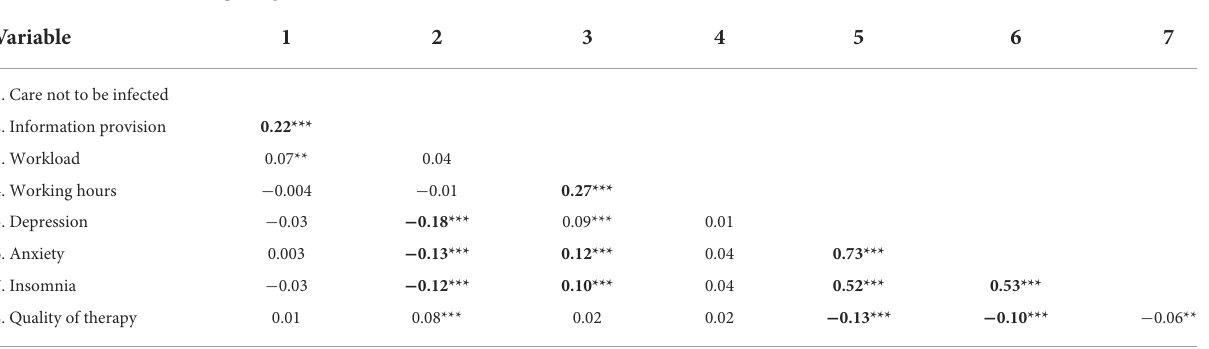
TABLE 2 Correlations among study